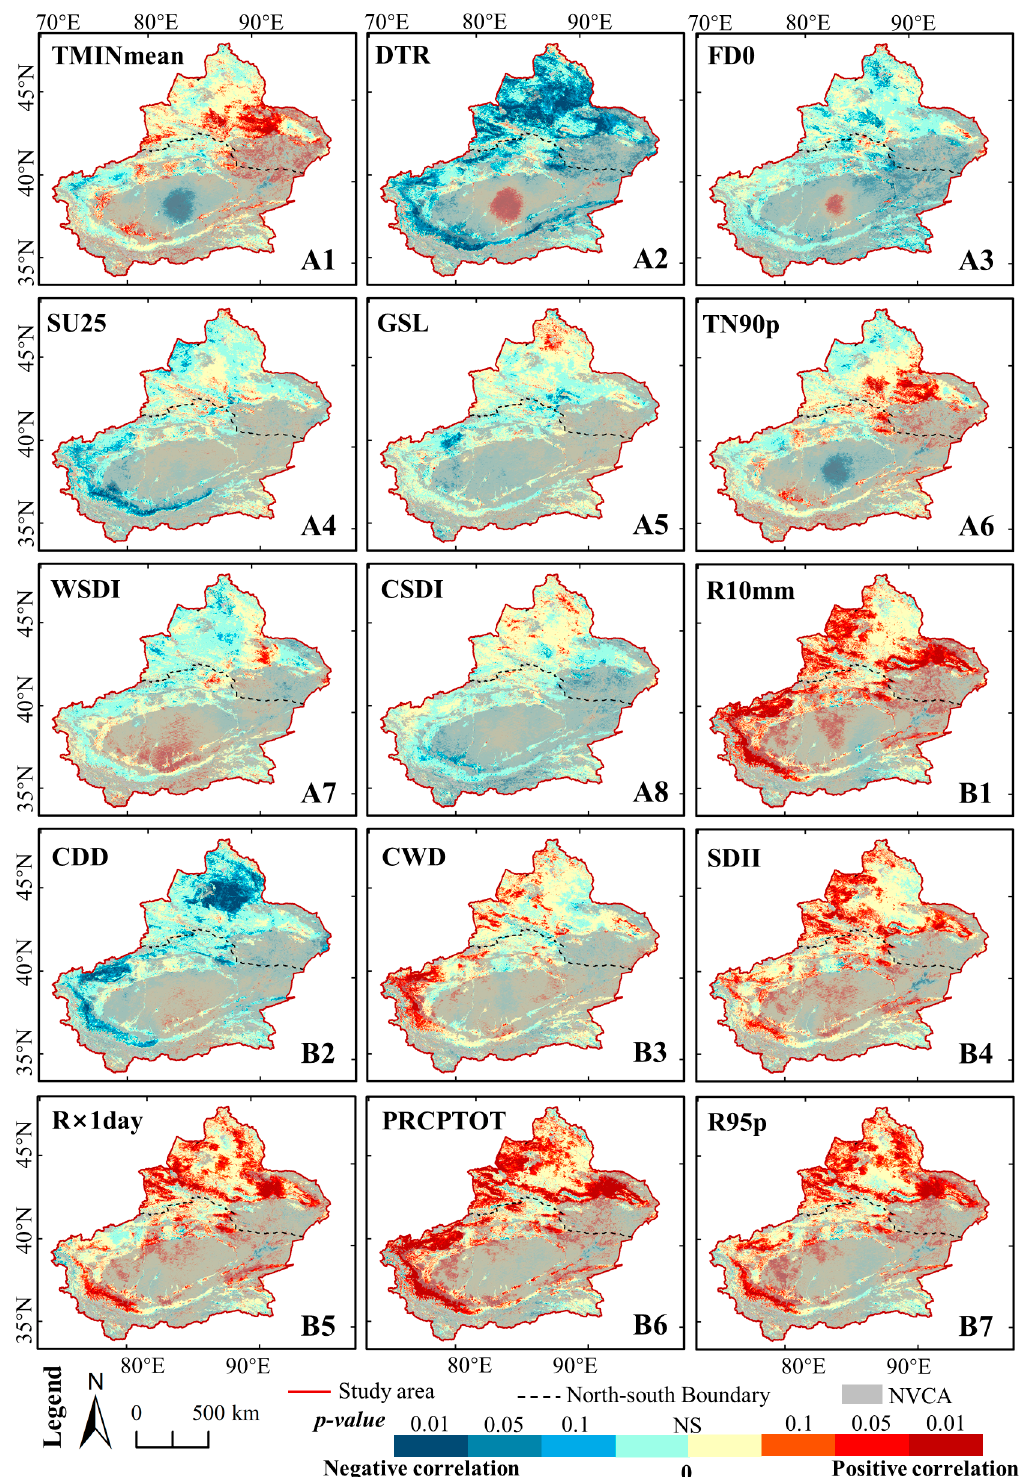
Figure 10. Pearson correlation coefficients between GNDVI and extreme climate indices in Xinjiang. The meanings of the indices are same as Figure 5. NS denotes the correlation is not significant. The NVCA denotes the non-vegetation covered areas.